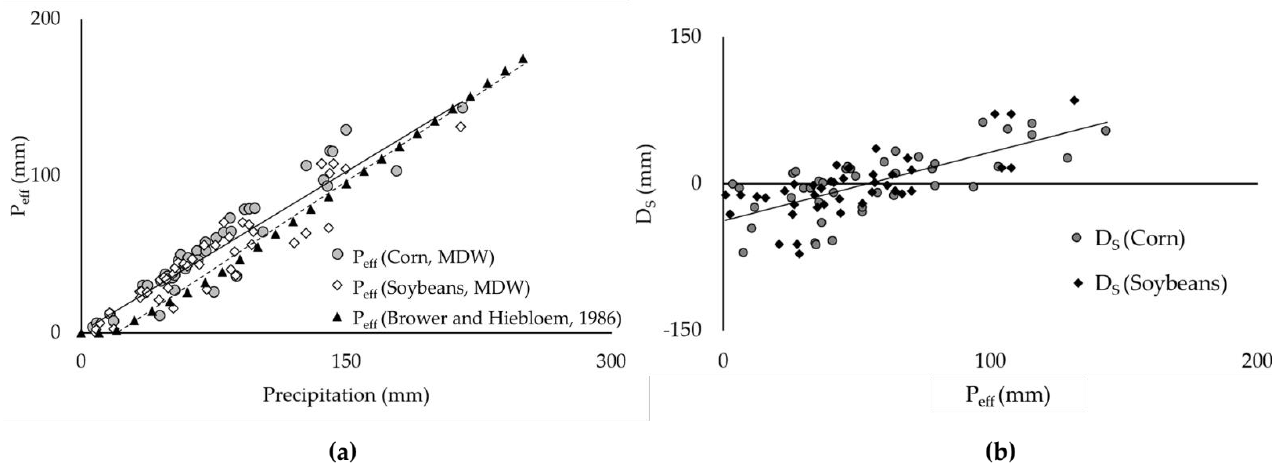
Figure 8. Scatter plots for the Matson Ditch Watershed (MDW) showing: ( a ) effective precipitation (P eff ) for corn and soybeans vs. monthly average precipitation compared to the effective precipitation (P eff ) vs. precipitation curve provided by the FAO [24]; and, ( b ) deficits or surpluses (D S ) vs. monthly average effective precipitation.